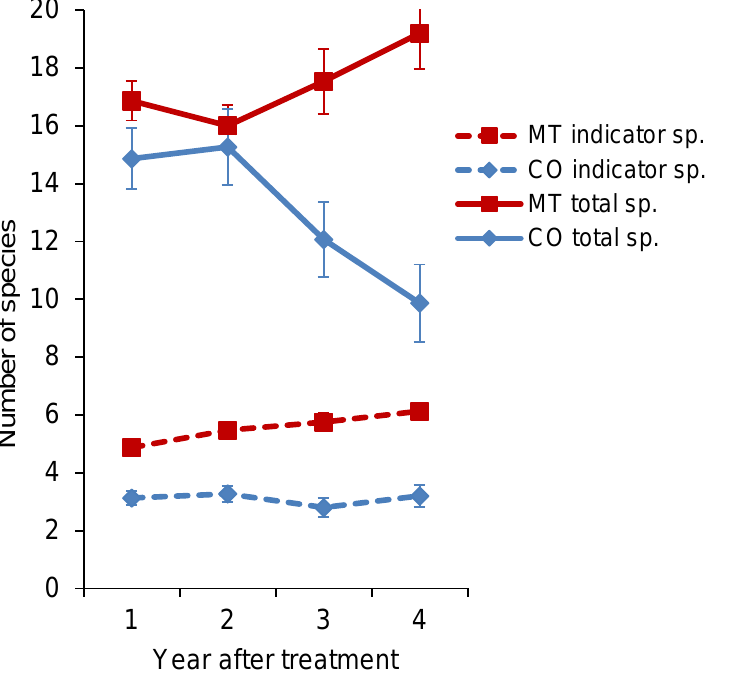
Figure 3. The mean total number of species (richness) and mean number of blanket bog indicator species recorded in the plots at Meall nan Tarmachan (MT) and Coire Odhar (CO) in the four years following treatment of bare peat. Error bars are ± 1 SE.